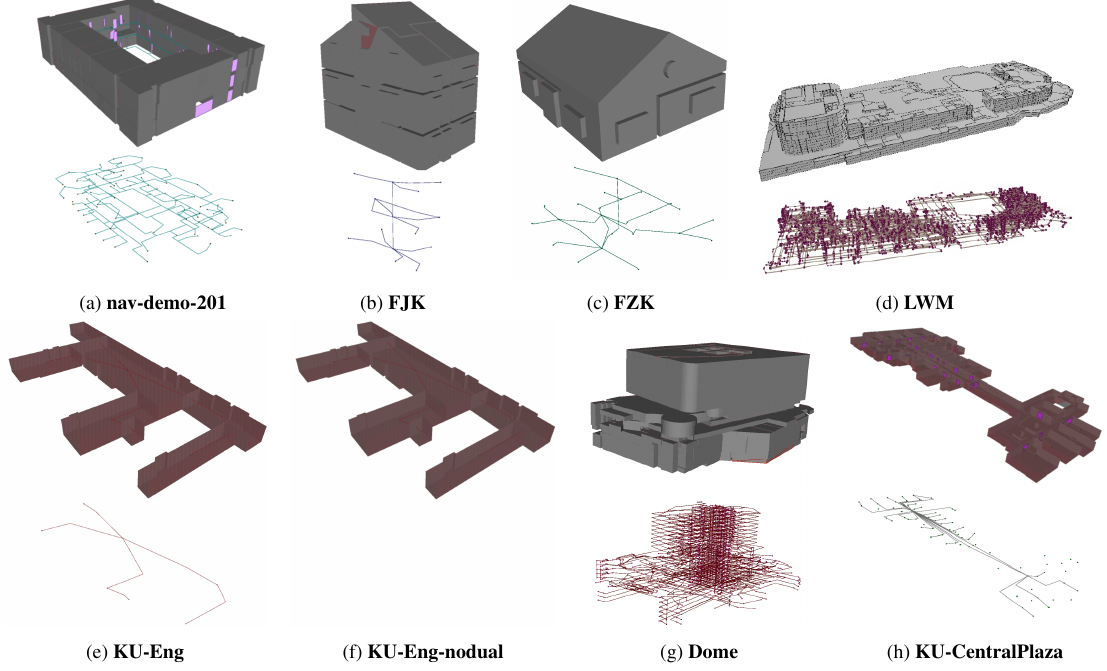
Figure 7. Datasets used for the experiments.